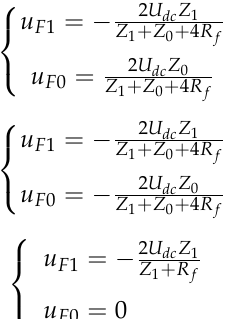
Figure 3. Fault points in the bipolar system. According to Figure 3, the modulus’ initial-voltage-fault traveling wave of the bipolar DC system under positive, negative, and bipolar ground fault can be expressed as shown in Equations (1)–(3) [16]: